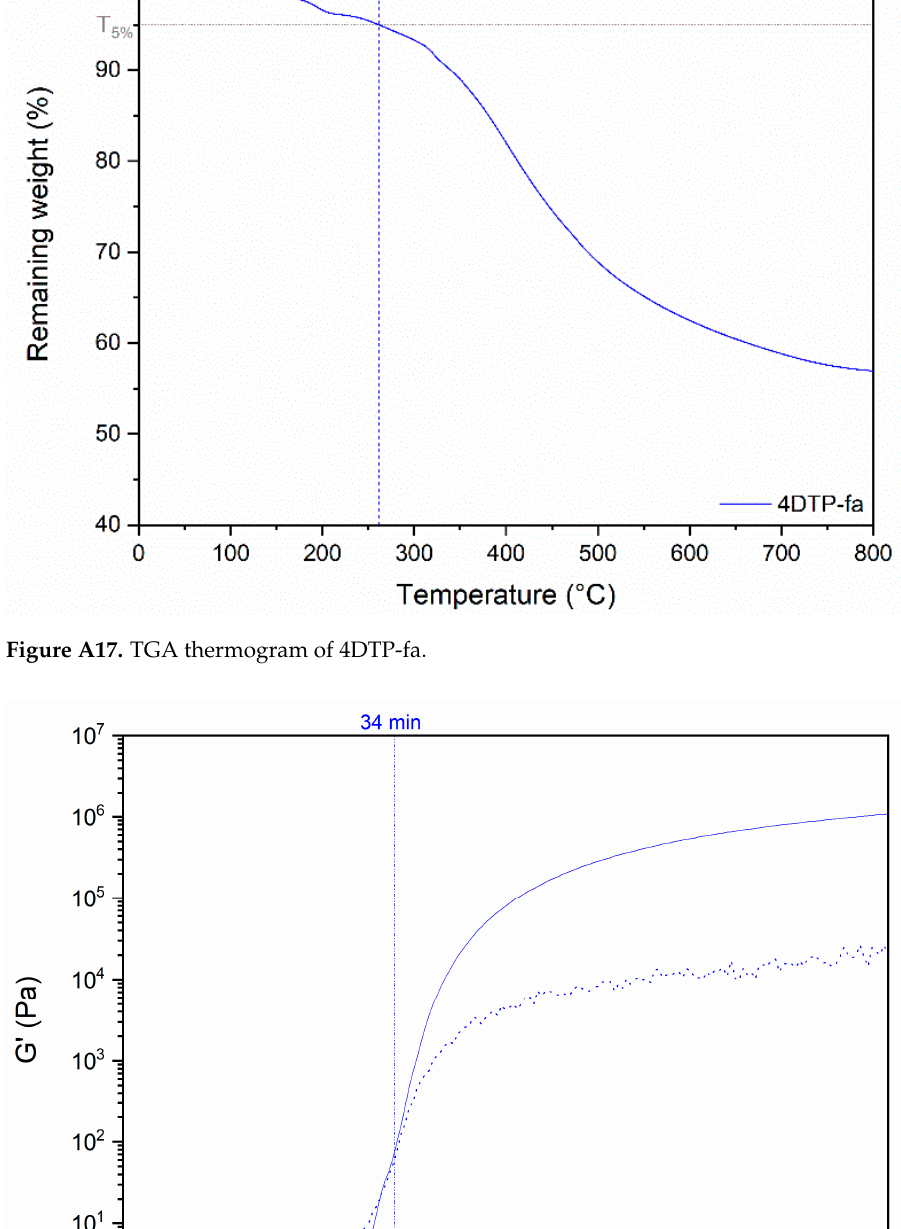
Figure A16. FTIR spectra of 4DTP-fa, poly(4DTP-fa) after curing at 170 °C for 1 h, and poly(4DTP- fa) after curing at 170 °C for 1h and post-curing at 190 °C for 1h and 210 °C for 1 h.